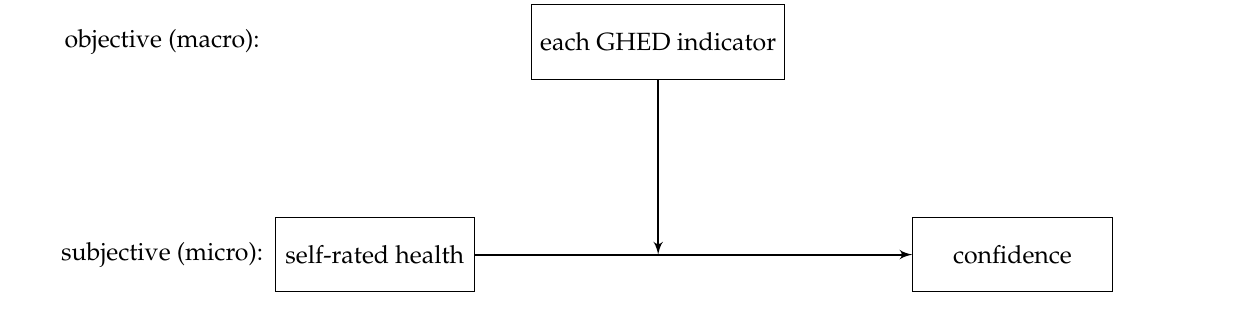
Figure 1. Link used for indicators weight; confidence = confidence in the health care system.